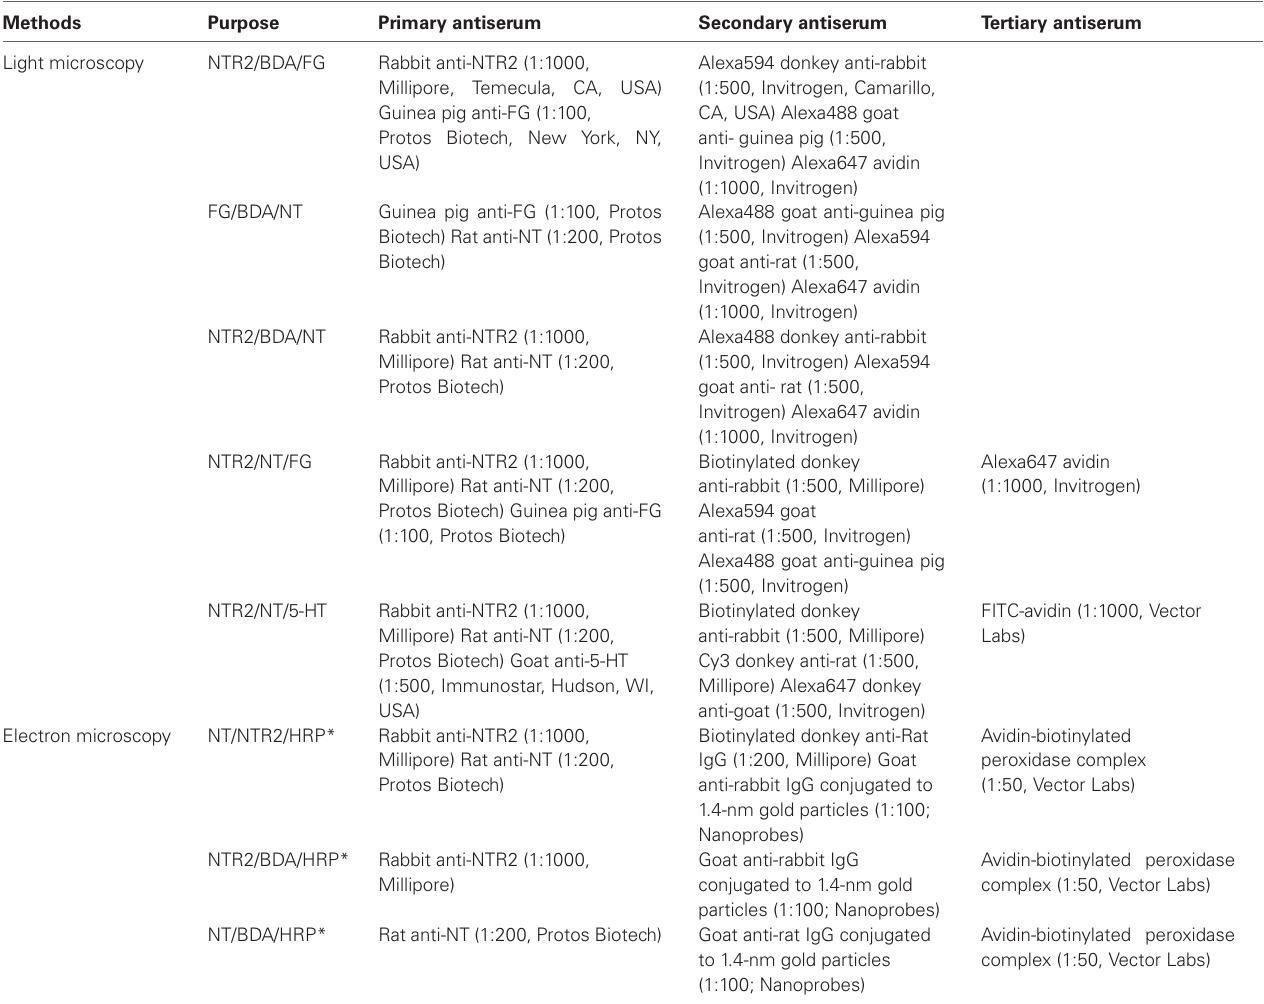
Table 1 | Antisera used in each